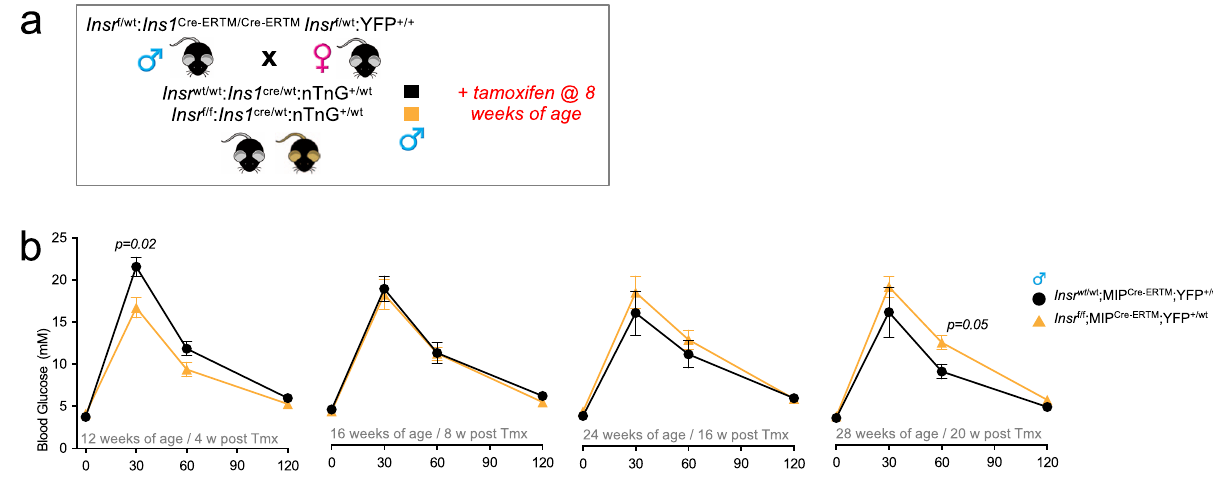
Fig. 9 Tail blood glucose levels (mM) from glucose tolerance tests in inducible β -cell speci fi c Insr knockout mice. a Breeding and experimental design for inducible β -cell speci fi c Insr knockout mice. b Glucose tolerance of Chow-fed Insr wt /wt ;MIP Cre-ERTM ;YFP + /wt (black lines, solid circles, n = 7)) and Insr f/f ;MIP Cre-ERTM ;YFP + /wt (yellow lines, solid triangles, n = 17) mice were examined at 4, 8, 16, and 20 weeks after tamoxifen injection at 8 weeks of age (3 × 200 mg/kg tamoxifen over a 1-week period). Data were analysed using repeated measures mixed-effects models. Data were analysed by a fi tted mixed-effects model with correction for multiple comparisons using Dunnett ’ s method. All data are presented as mean values ± SEM. Source data are provided as Source Data fi